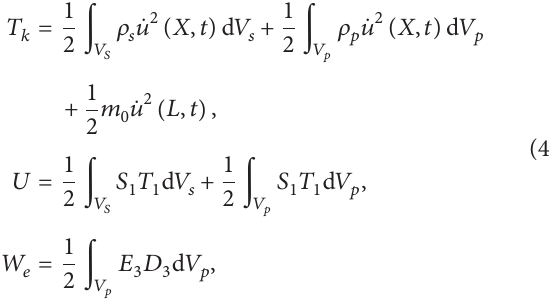
Figure 2: Schematic of the two permanent magnets in repelling